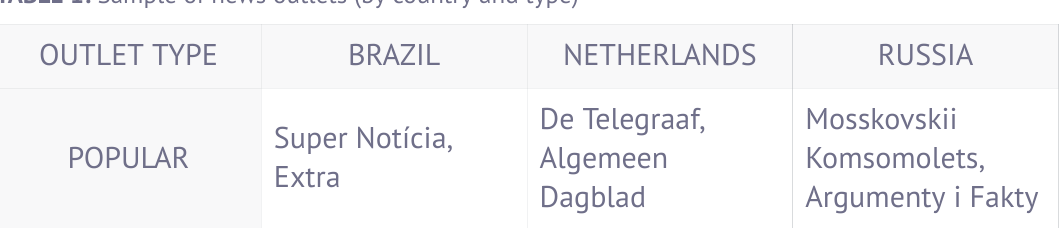
TABLE 1: Sample of news outlets (by country and